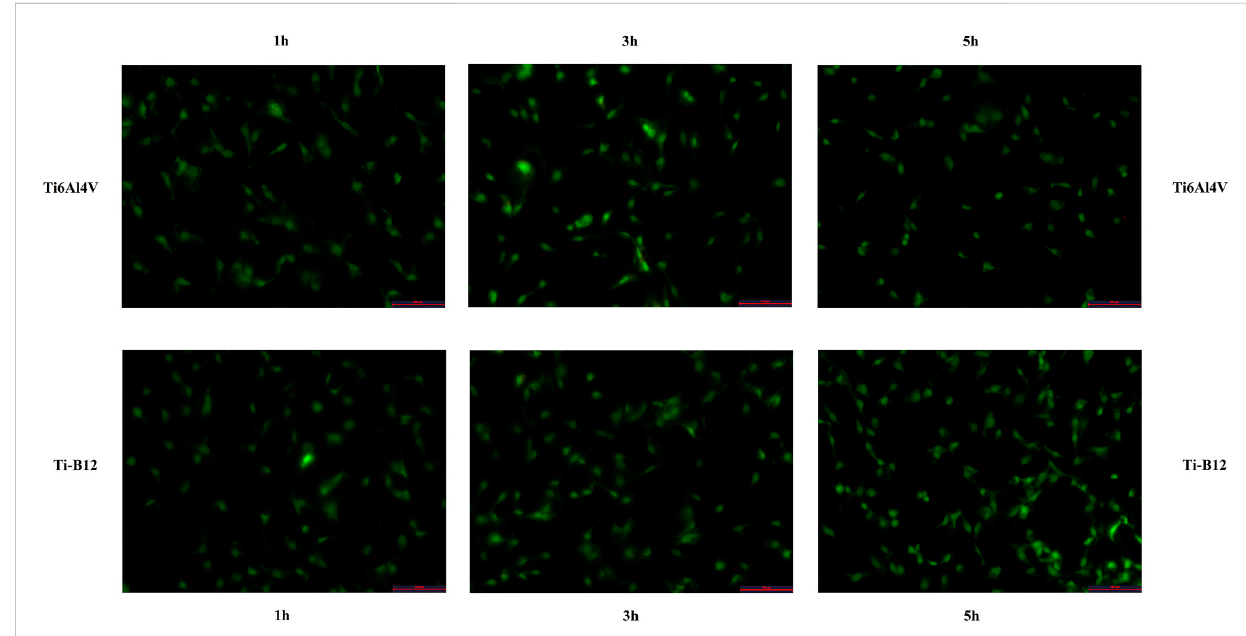
FIGURE 6 The adhesion ability of MC3T3-E1 on the surface of osteoblasts of two materials was observed under a fl uorescence